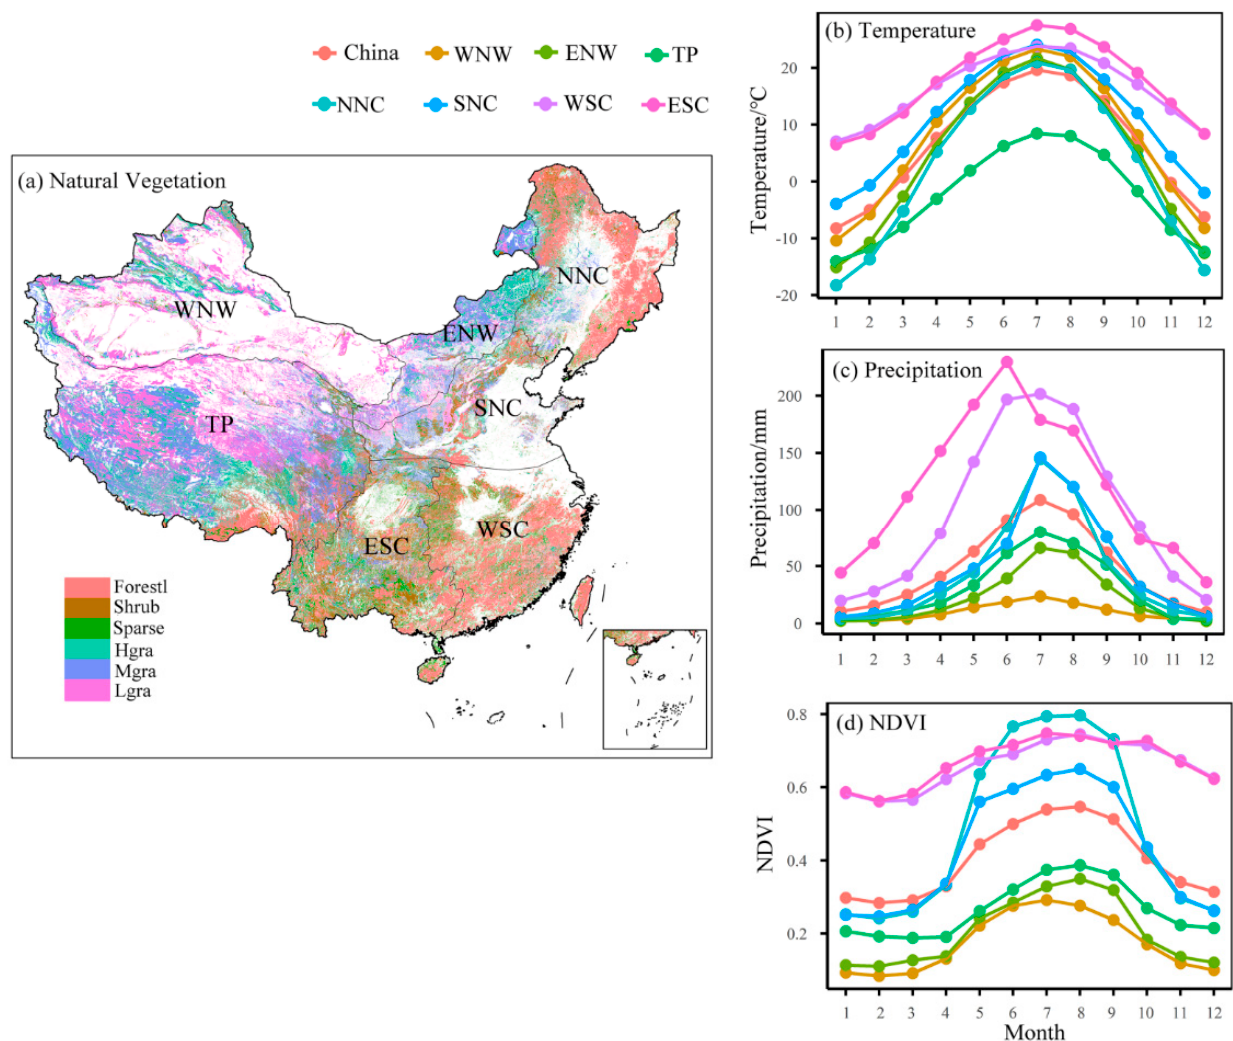
Figure 1. The distributions of natural vegetation ( a ), monthly temperature ( b ), precipitation ( c ), and Normalized Difference Vegetation Index (NDVI) ( d ) across China. Abbreviations: TP—Qinghai-Tibet alpine region; WNW—Western arid and semi-arid region; ENW—Eastern arid and semi-arid region; SNC—Southern North China; WSC—Western South China; ESC—Eastern South China; NNC—Northern North China; NDVI—Normalized Difference Vegetation Index.